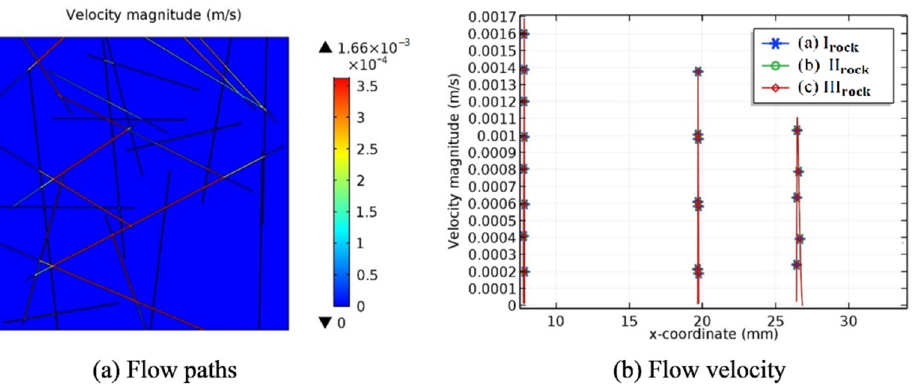
Figure 12. Flow paths ( a ) and flow velocity values ( b ) at the outlets of model A3 with various matrix permeabilities. ( b ) The horizontal axis and vertical axis indicate the x-coordinate and methane flow velocity magnitude at each outlet boundary, respectively.